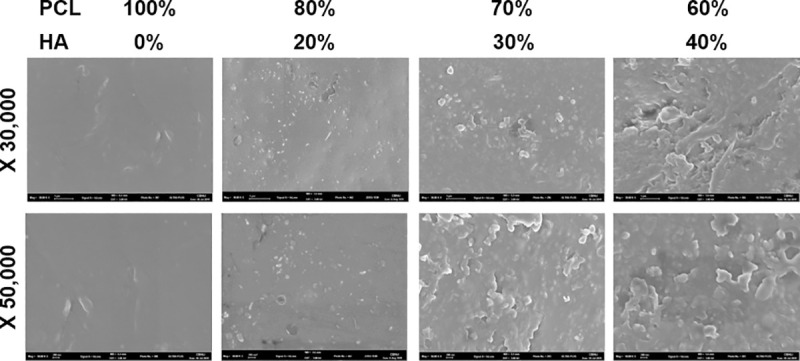
Analysis of microstructure of polycaprolactone (PCL)/hydroxyapatite (HA) composite using scanning electron microscope for production of the ocular implant.As the percentage of HA increased, more particles were seen. Even distribution of HA nanoparticles in the PCL scaffold was seen, indicating that our printing method was suitable for implant production.